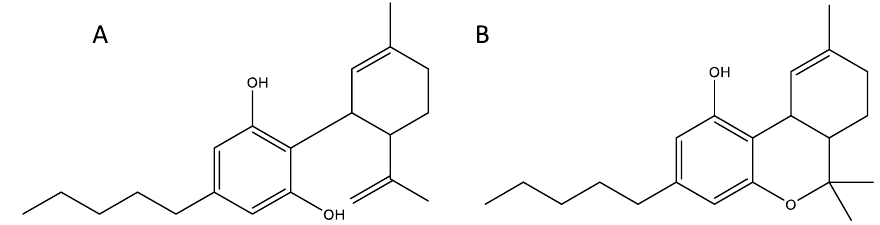
Fig. 1 Molecular structures of A CBD and B ∆9-THC, two high value cannabinoids that are produced in high abundance in the cannabis